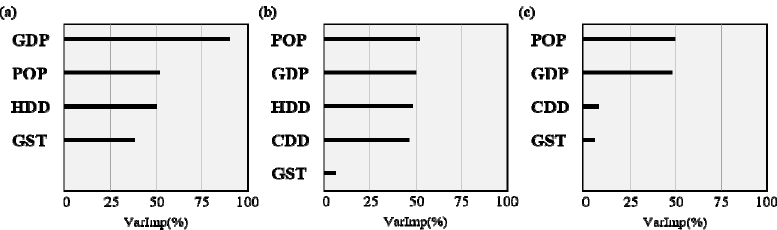
Figure 8. Importance of covariates in the Cubist regression models for estimation of BECCE intensity: ( a ) region Ⅰ , ( b ) region Ⅱ , and ( c ) region Ⅲ .